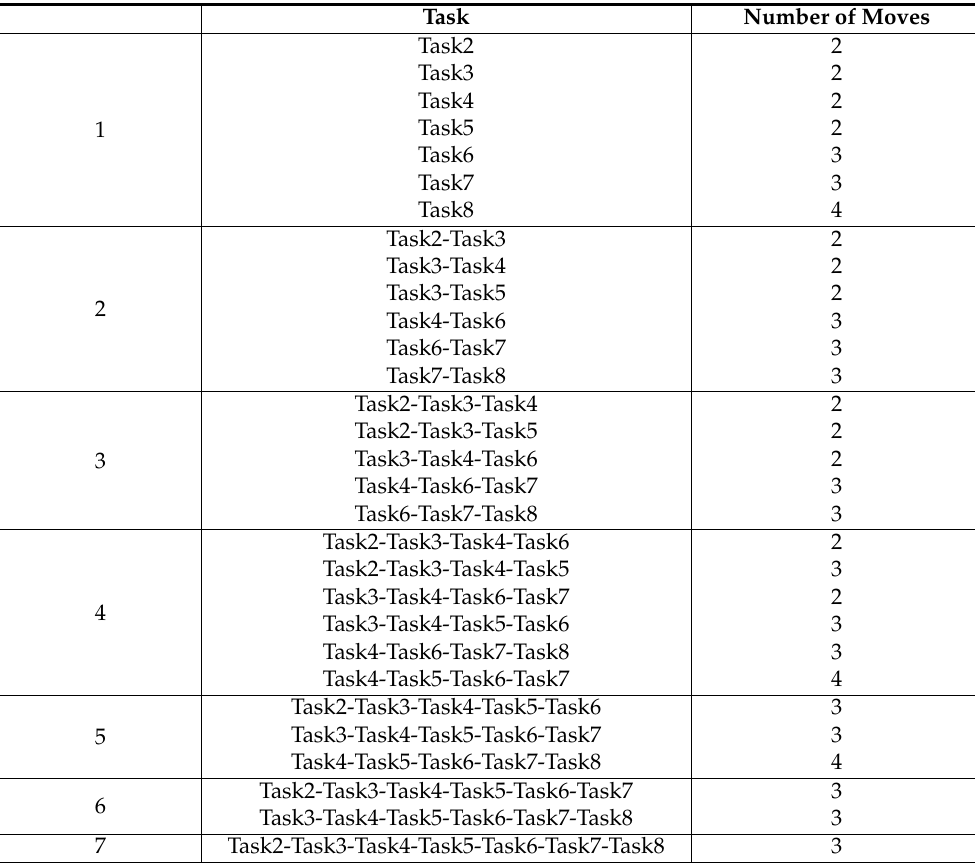
Table 3. Task-linked list.